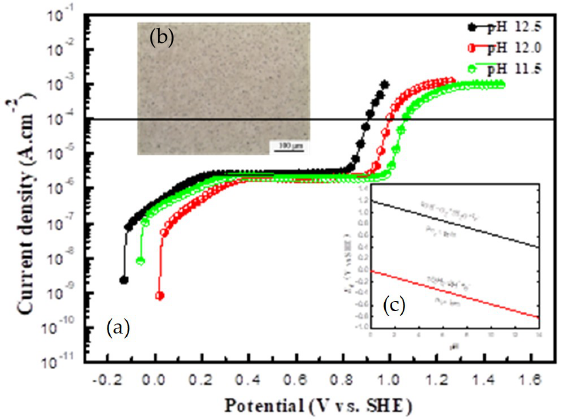
Figure 2. Anodic polarization curves for reinforcing bars’ in simulated concrete pore solutions with various pH values ( a ). The corrosion morphology after the polarization test ( b ), and the water Pourbaix diagram ( c ).